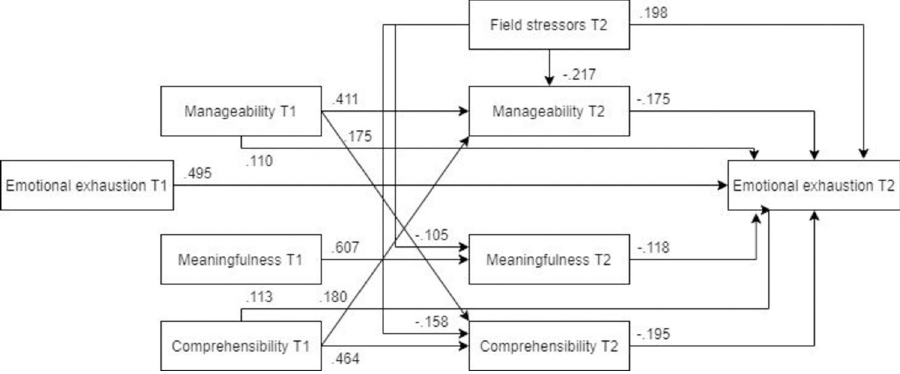
Fig 11. Optimized structural equation model for emotional